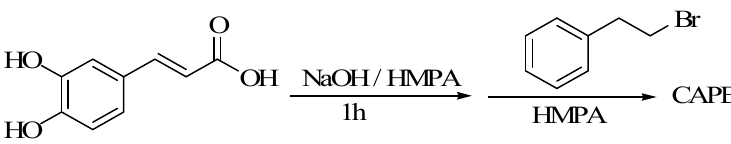
Figure 4. The scheme of halogen substituted hydrocarbon.